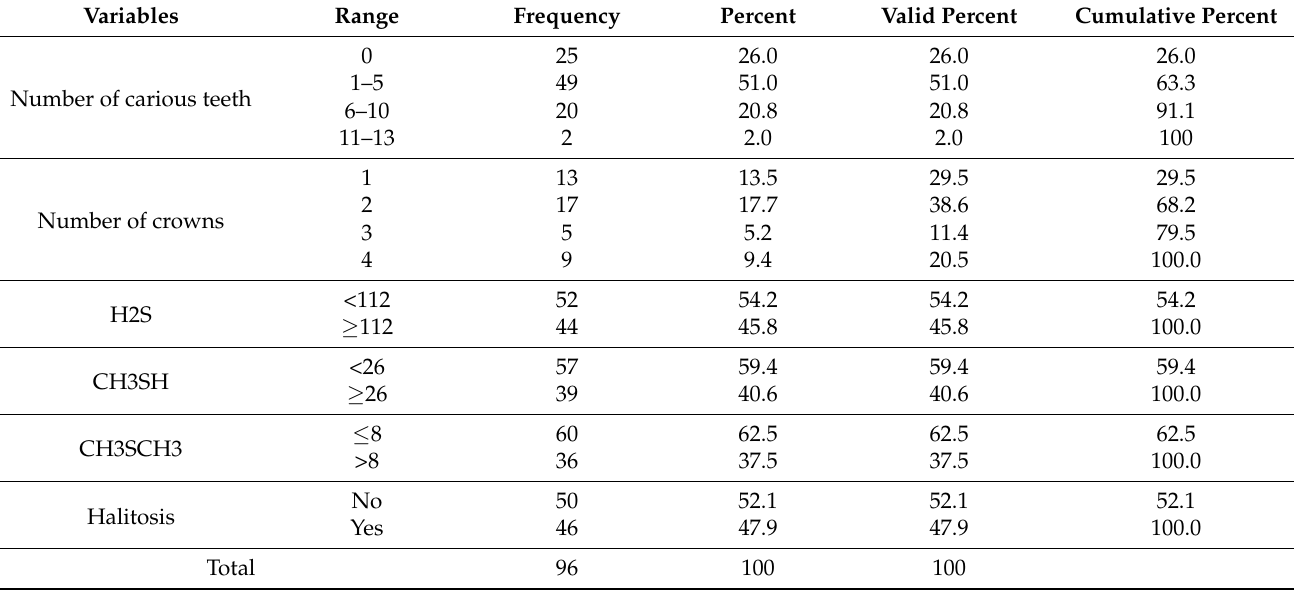
Table 2. Frequency table of different clinical and tested variables investigated in the study ( n = 96). Variables